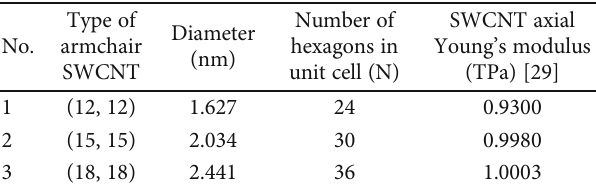
Table 8: Diameter, number of hexagons in unit cell, and axial Young ’ s modulus of armchair